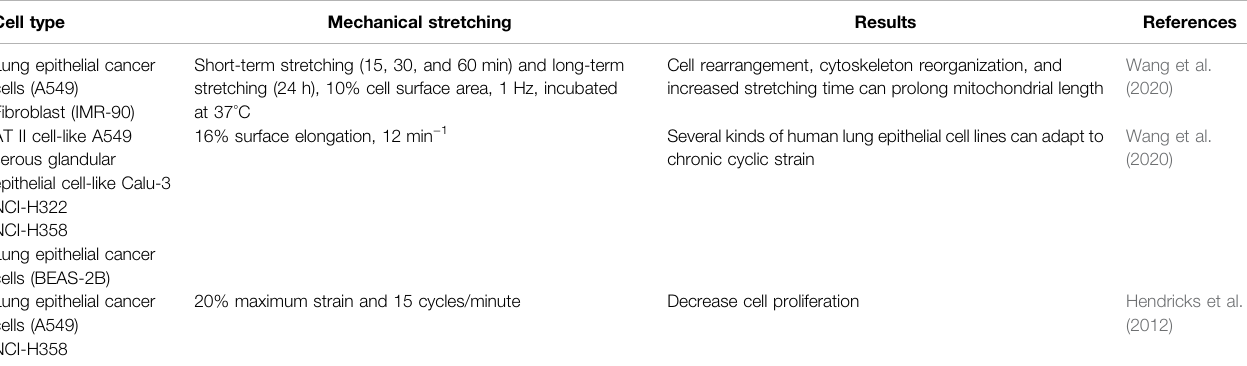
TABLE 1 | Stimulation experiments of lung cancer cells by mechanical